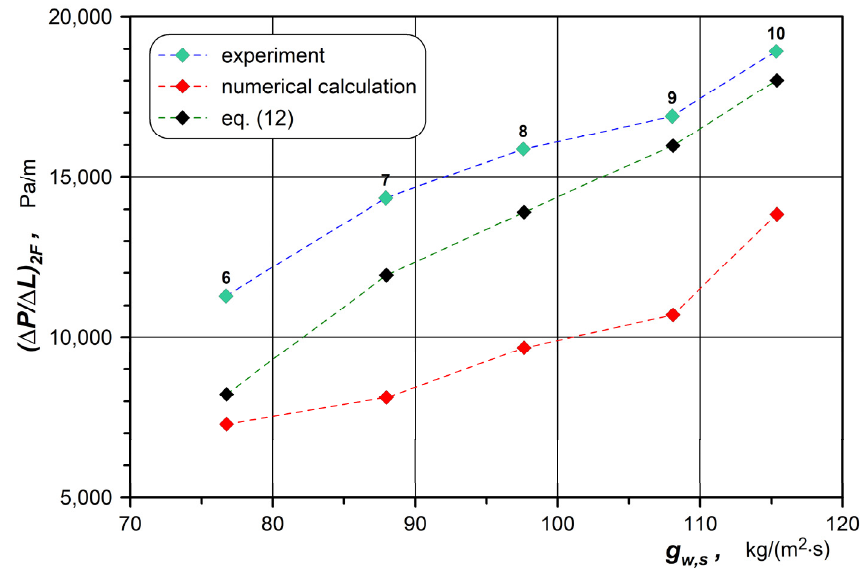
Figure 11. Comparison of the pressure drop values derived by application of various